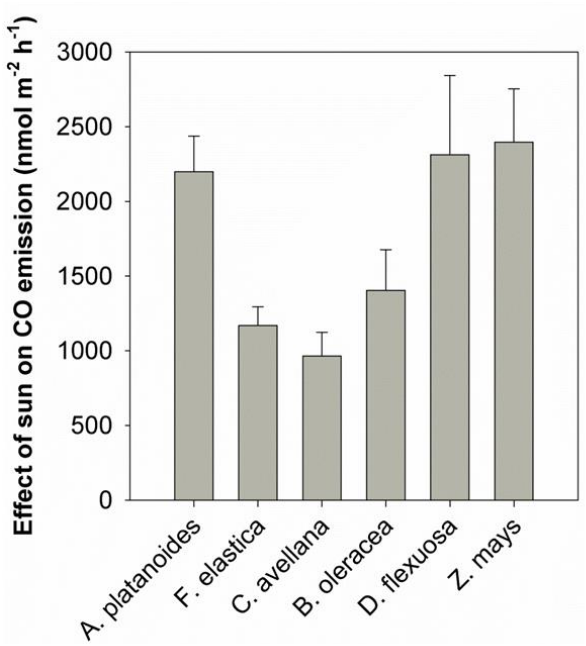
Fig. 2. The effect of solar radiation on the CO emission rates (ER) by leaves (mean ± S.E. of ER light – ER dark ) . Measurements were conducted with a temperature-controlled chamber at 25 ◦ C. The order of treatments (full sun and dark) was alternated be- tween replicates. For the temperature-controlled chamber mea- surements the mean ( ± S.E.) level of UV-B (280–315nm) was 0.51 ± 0.03Wm − 2 and the mean ( ± s.e.) PAR was 789 ± E.E. 47µmolphotonsm − 2 s − 1 .